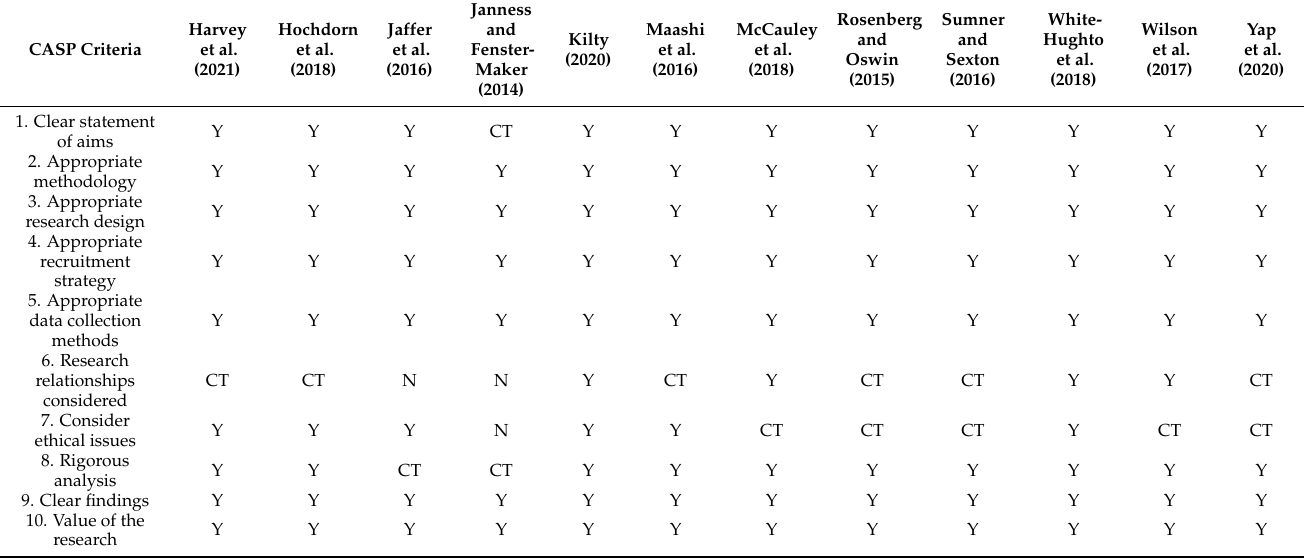
Table 2. CASP quality